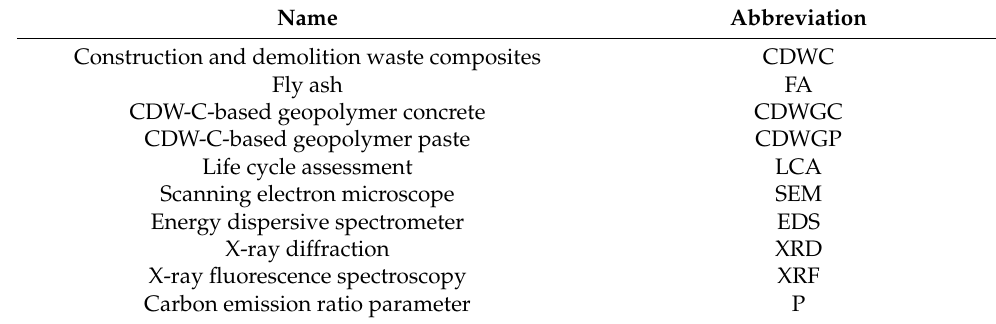
Table 1. Abbreviation list.